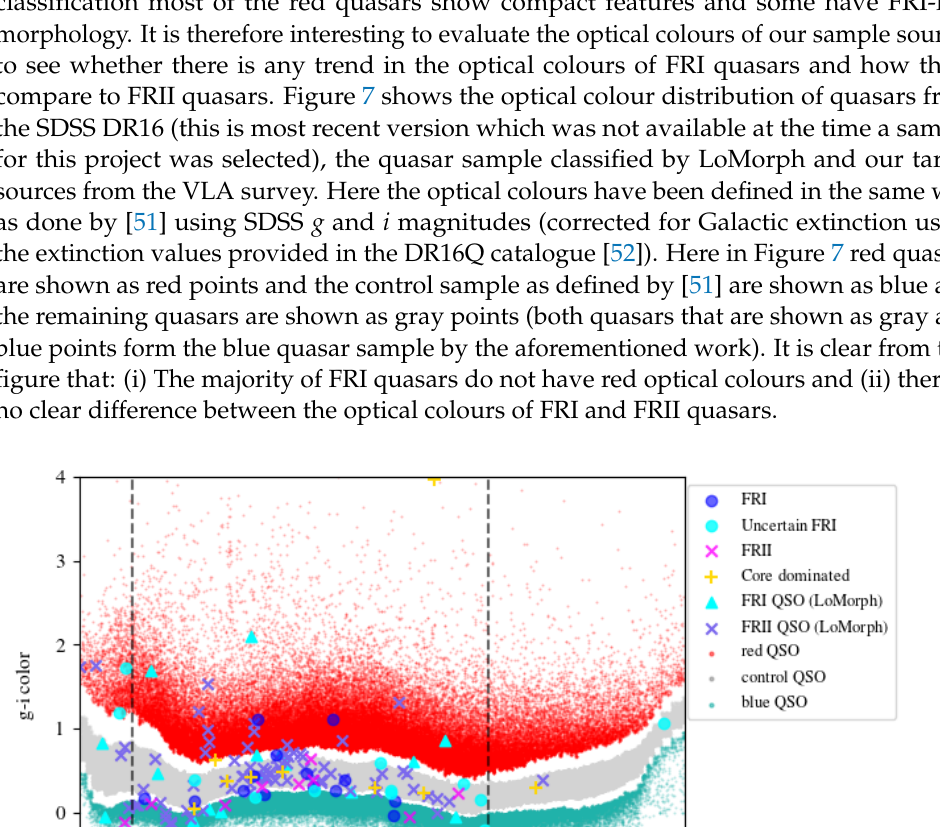
Figure 7. The optical colour (SDSS g - i ) distribution of quasars from the DR16Q catalogue, our target sample and the quasars sample with clean classification by LoMorph. Red quasar are quasars with red optical colours, control quasar indicate the control sample (the 10% of quasars around the median of the g - i distribution) and pure blue colour quasars are given as blue quasar. The optical colour classification is based on [50,51]. The dashed lines show the range of redshift within which the optical colours are reliable as described by [50,51]. Symbols of our quasars sample are as above. For a clean representation, we show FRII quasars and uncertain FRIIs using the same